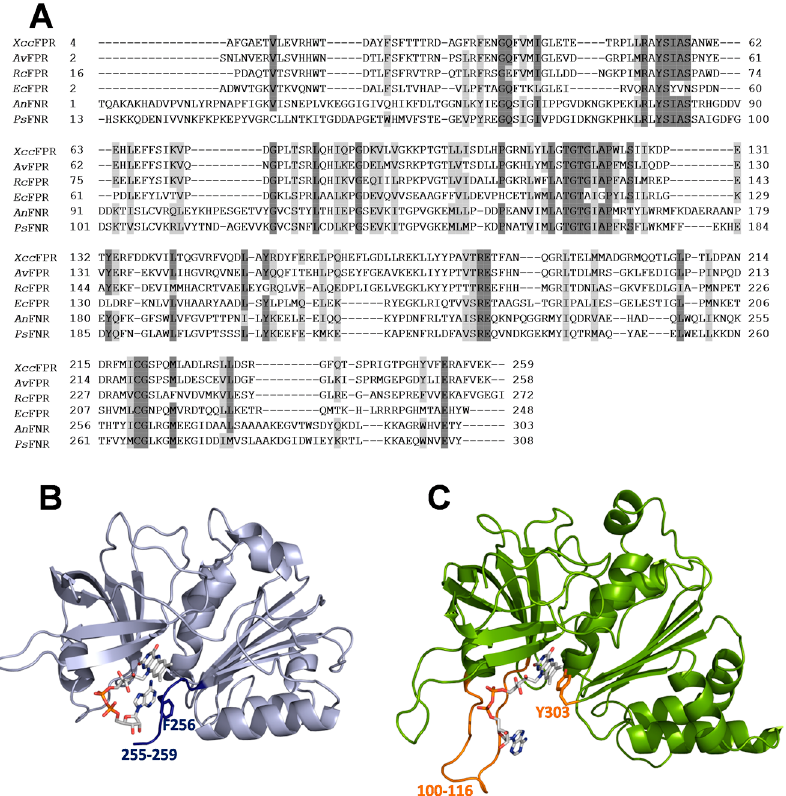
Figure 1. ( A ) Structural alignment of bacterial FPRs from Xcc ( Xcc FPR), Azotobacter vinelandii ( Av FPR), Rhodobacter capsulatus ( Rc FPR) and Escherichia coli ( Ec FPR) and plastidic FNRs from Anabaena PCC 7119 ( An FNR) and Pisum sativum ( Ps FNR). Similarities are shown in light grey and identities in dark grey. Structural models for ( B ) Xcc FPR (4b4d, light blue) and ( C ) An FNR (1que, green). Proteins are in cartoon and FAD cofactors are in sticks. In Xcc FPR, A255 faces the flavin re -face (shown in sticks) and is followed by a C-terminal extension (dark blue) that stacks on the adenine moiety of FAD contributing to its folded conformation. In An FNR, the residue stacking the flavin re-face is the C-terminal Y303 (orange sticks), and the FAD is in an extended conformation towards the 100-116 loop (orange) that is absent in FPRs.